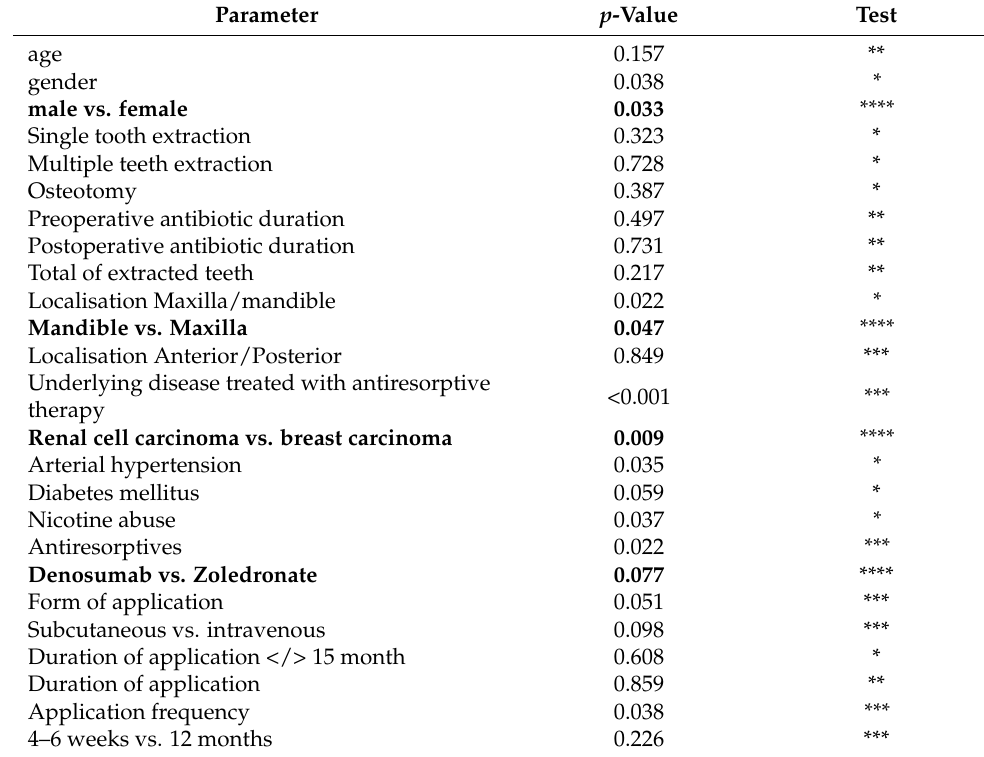
Table 2. Showing all statistical values among the patients with significance level p ≤ 0.05). Fisher’s exact test, chi-square test and Mann–Whitney U test were applied. After reaching a significance level, a logistic regression (marked in bold) was performed for a more precise